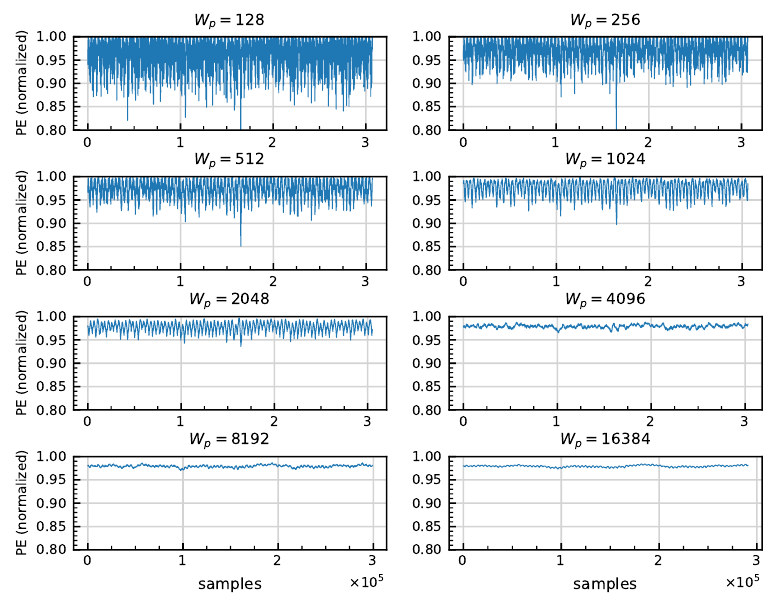
Figure 2. Several permutation entropy (PE) signals calculated from a D2 bearing at 10 rpm, with O p = 3 and varying W p .